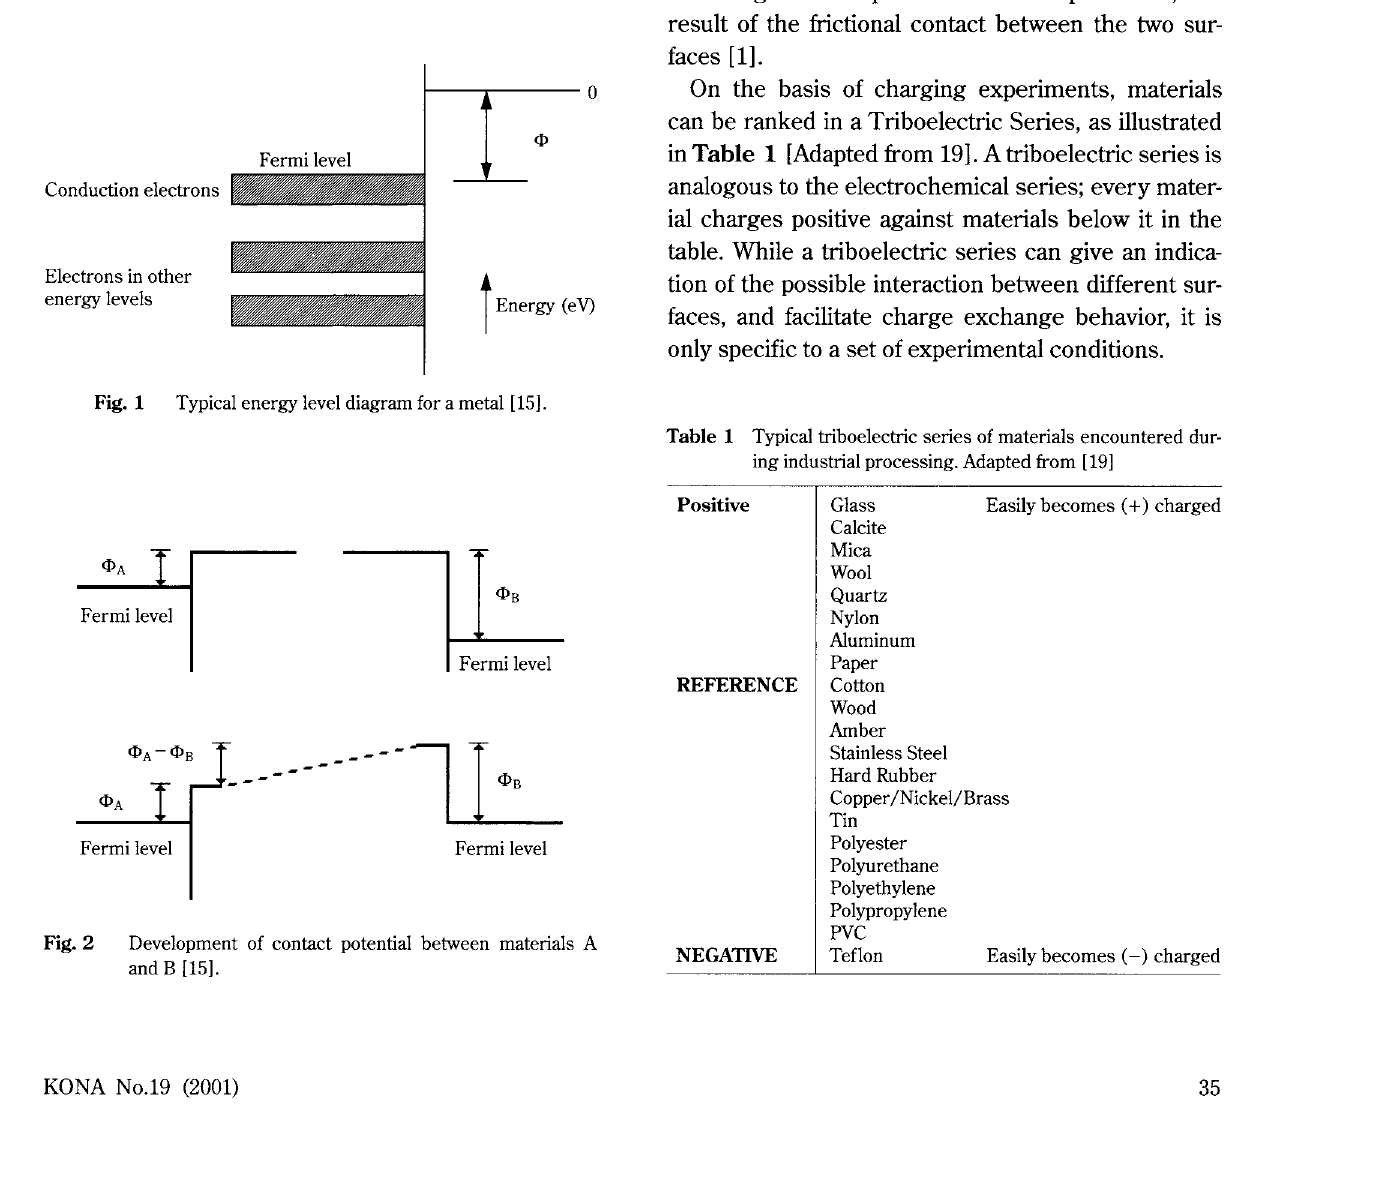
Fig. 2 Development of contact potential between materials A and B [15].